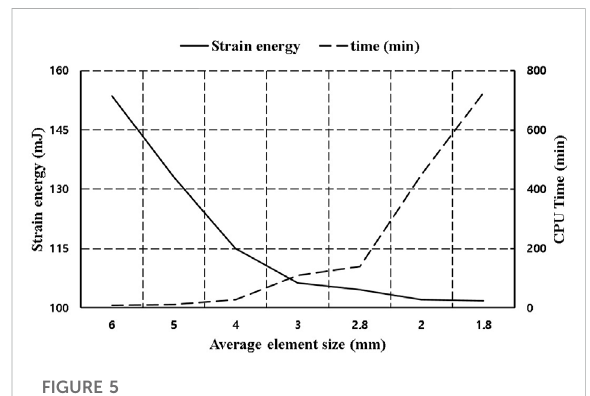
FIGURE 5 Analysis time and strain energy corresponding to element size.